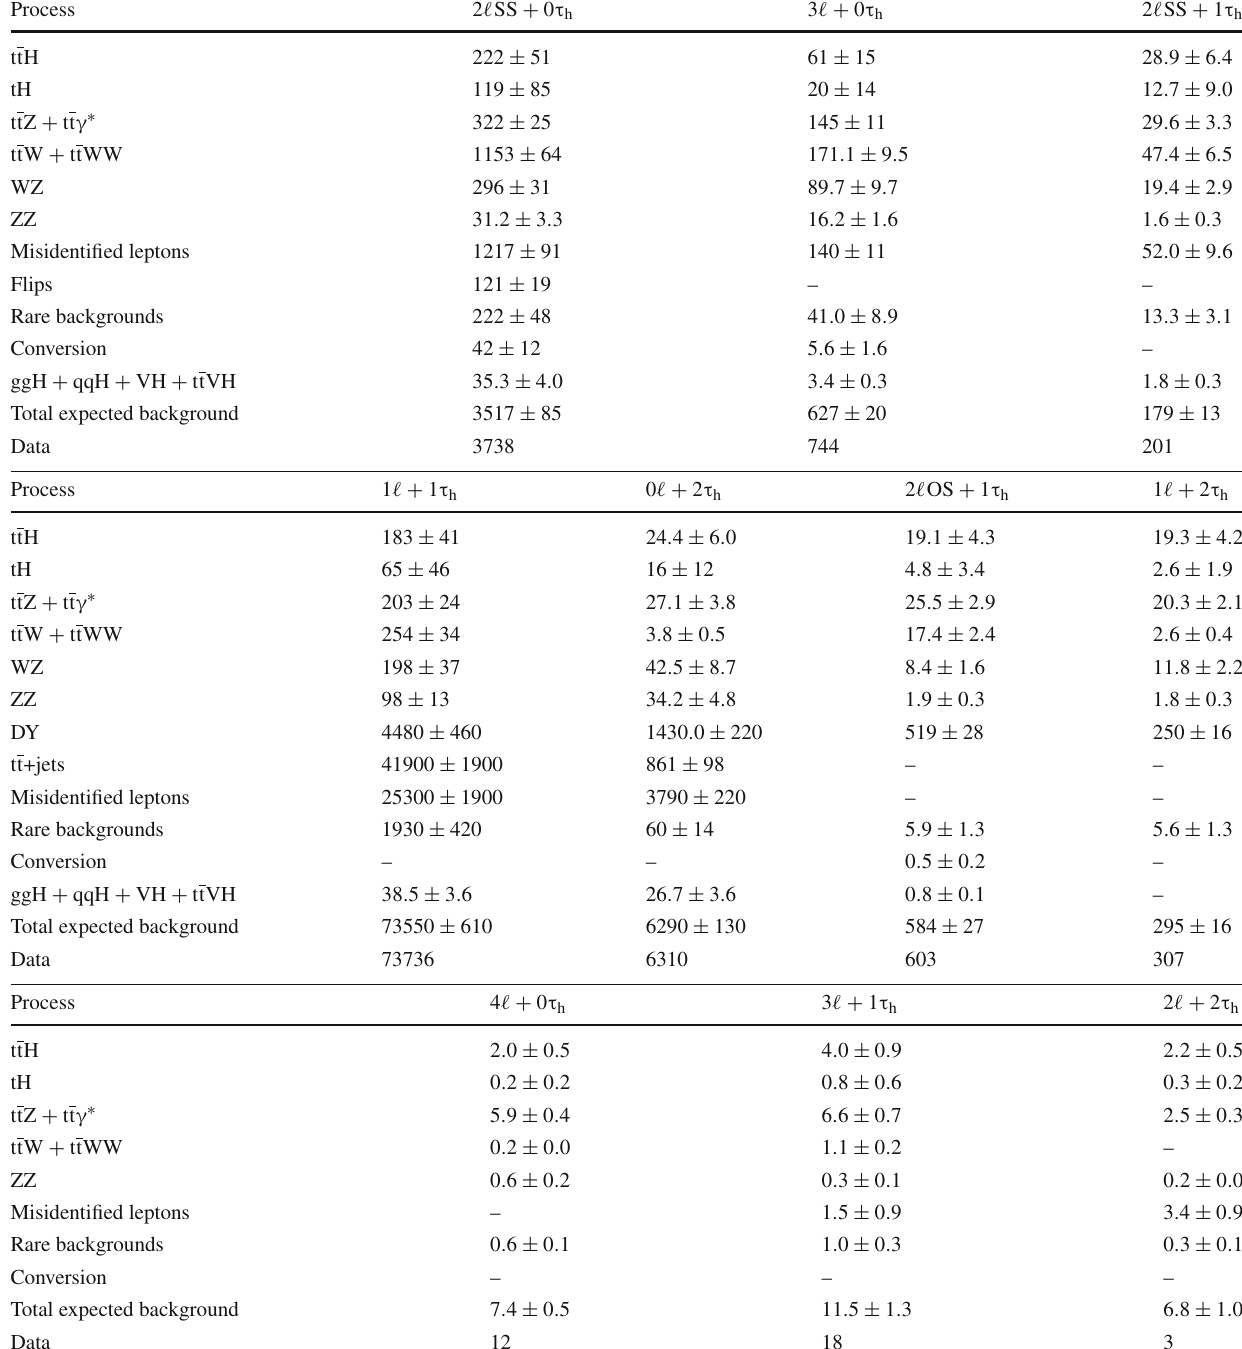
Table 8 Number of events selected in each of the ten analysis channels compared to the event yields expected from the ttH and tH signals and from background processes. The expected event yields are computed for the values of nuisance parameters and of the POI obtained from